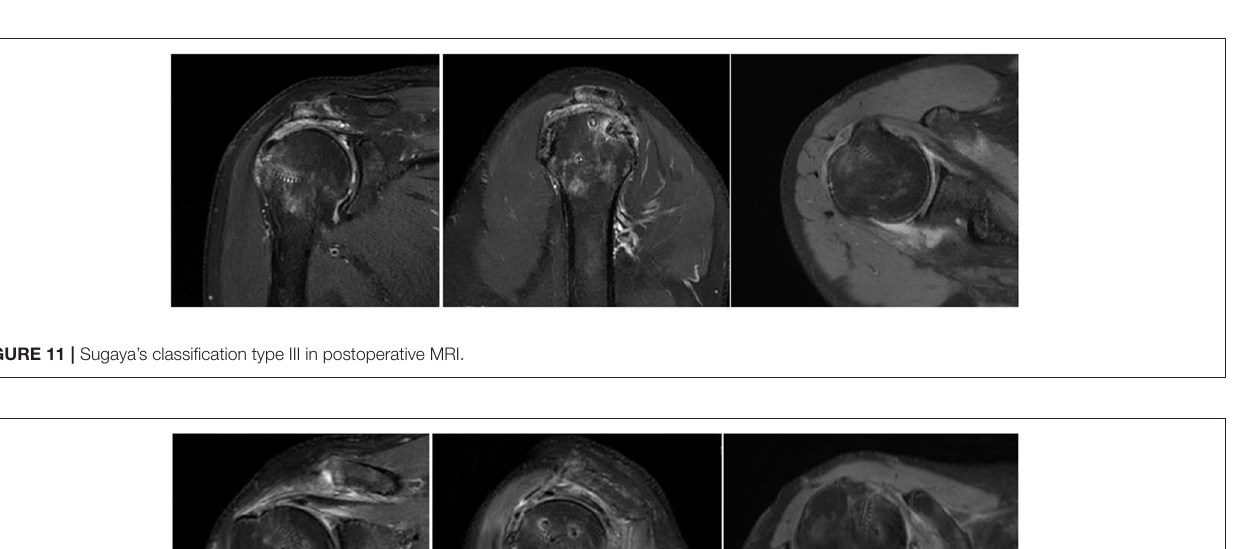
FIGURE 10 | Sugaya’s classification types I and II in postoperative MRI.